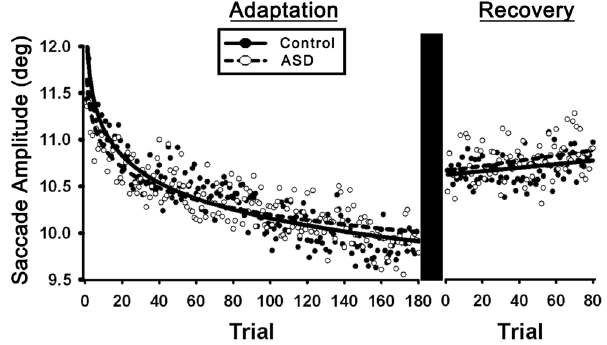
Figure 2. Saccade amplitudes for subjects with autism spectrum disorders (ASD) and healthy controls during adap- tation and recovery. The natural logarithmic model fit is presented for adaptation, and each data point represents the group mean for an individual trial. Subjects with ASD showed reduced rates of learning (p , .01). The linear fit is presented for recovery data. There was no difference in the rate at which subjects with ASD and healthy controls increased their amplitudes during the recovery phase